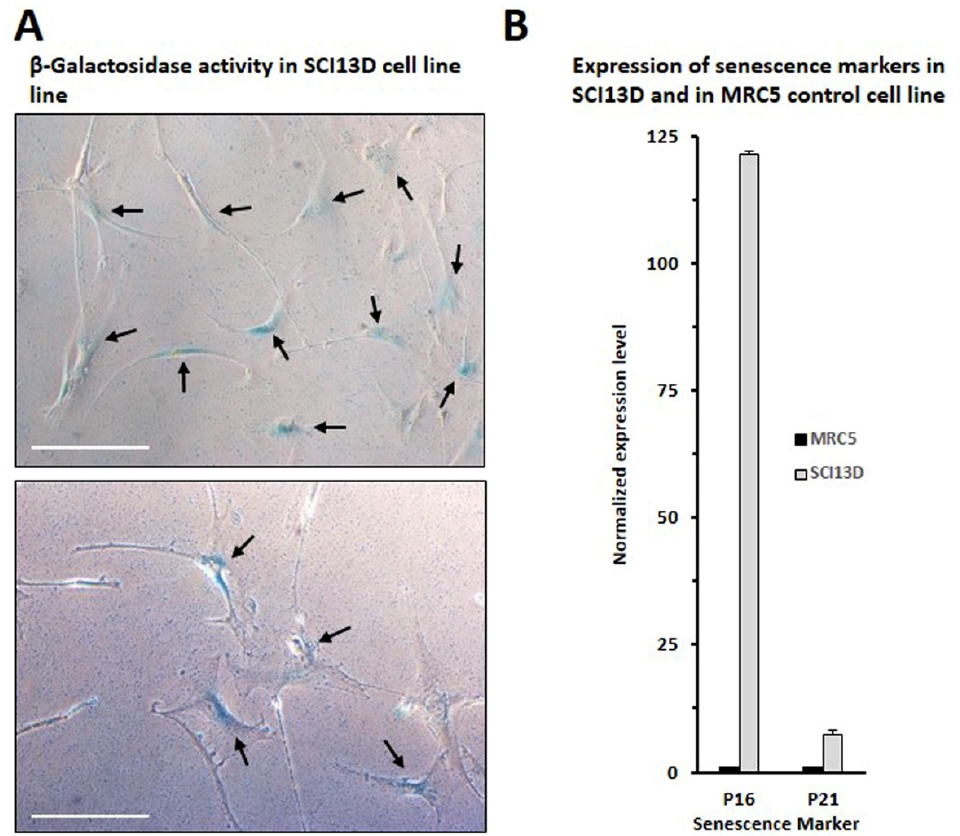
Figure 3. Assessment of senescence markers in SCI13D cell line. ( A ) Evaluation of β -galactosidase activity in SCI13D cell line; scale bar = 25 µ m; ( B ) p16 and p21 mRNA levels of expression in SCI13D cell line and in the fibroblast cell line of control MRC5, as detected by quantitative real-time PCR. Histograms depict normalized average values ± SD of three determinations.